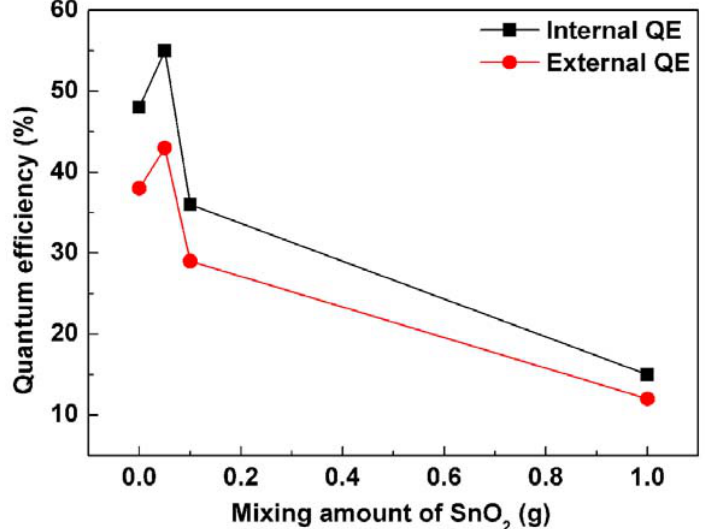
Figure 4. External and internal quantum efficiencies (QEs) of the β -sialon:Eu 2+ deposits, with various mixed amount of the SnO , prepared by the EPD process at 10 s depositing 2 time as a function of the SnO addition amount (0–1 2